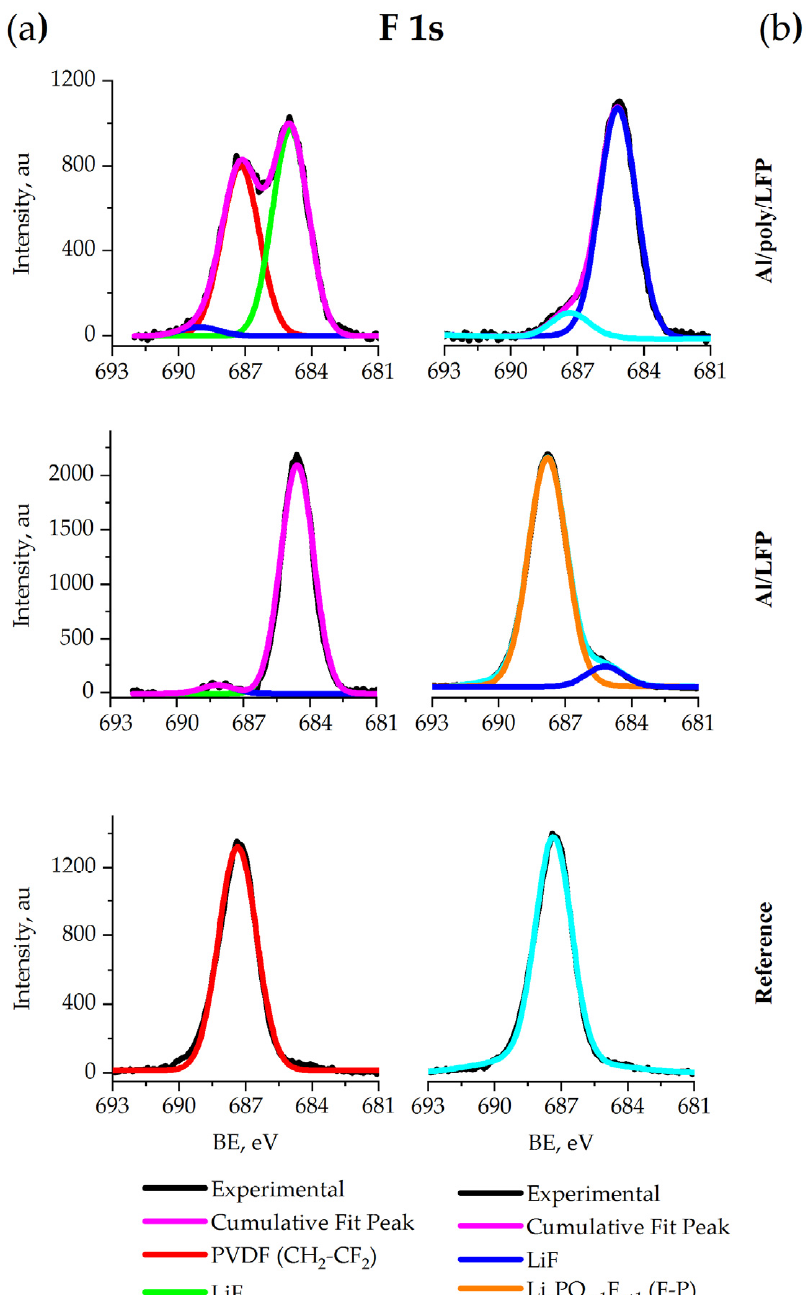
Figure 12. XPS spectra of F 1s for coin ( a ) and pouch ( b ) cells. The Fe 2p spectra of all coin cell electrodes (Figure 13a) contain two peaks 1 and 3 located at 710 eV and 723 eV, respectively, that correspond to the bands of Fe 2p Fe 2p in LiFePO 4 [69]. In the same spectra, satellite peaks 2 and 4 at 715 eV and 729 eV, 1/2 respectively, relate to the transition of metal spectra [64]. The peak at 723 eV disappeared from the spectrum of the unprotected electrode extracted after the short-circuit